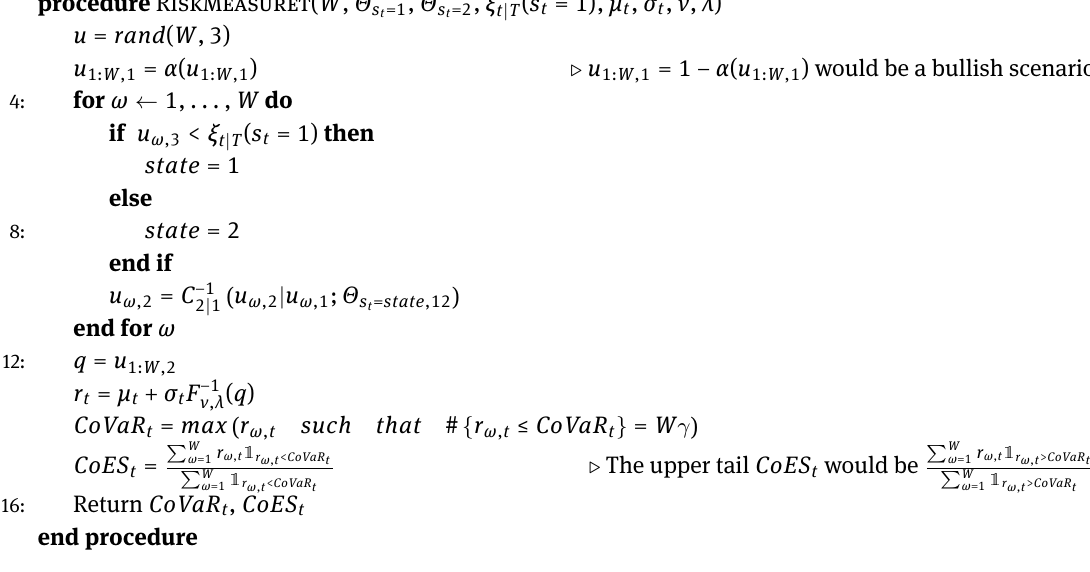
Algorithm 3: Assessment of the risk measures of the stock market returns at time t under a certain scenario for oil